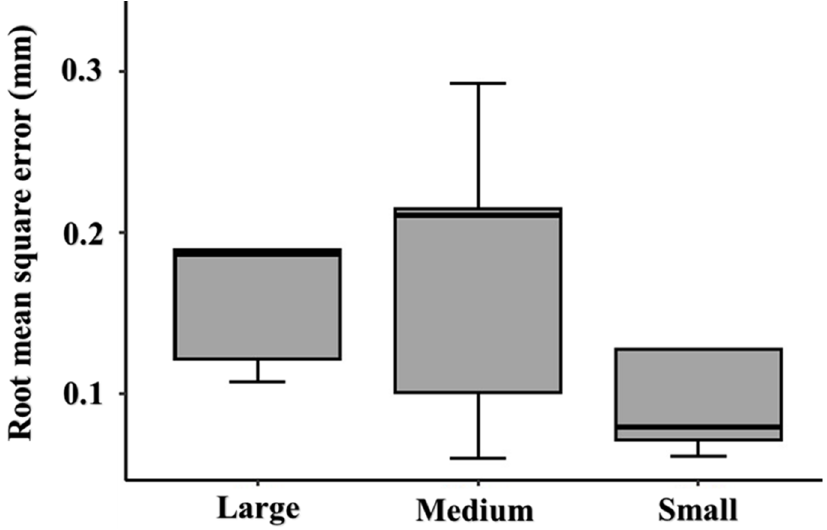
Figure 3. Box plot representing comparative analysis of average deviation values within each group. a color-coded map. The shaded area in the red zone indicates that the post-sterilized implant’s region is more than the reference’s, indicating that the deviation value is positive. The shaded area in the blue zone denotes a lower post-sterilized implant area than the reference, indicating a negative deviation value. The green zone represents the overlap area between the pre-and post-sterilized implant models. As noticed in Figure 4, most areas are green, indicating that the post-sterilized implant’s size is comparable to the reference model. Furthermore, a few areas around the edge of the implant exhibited a slight negative incongruence from the reference